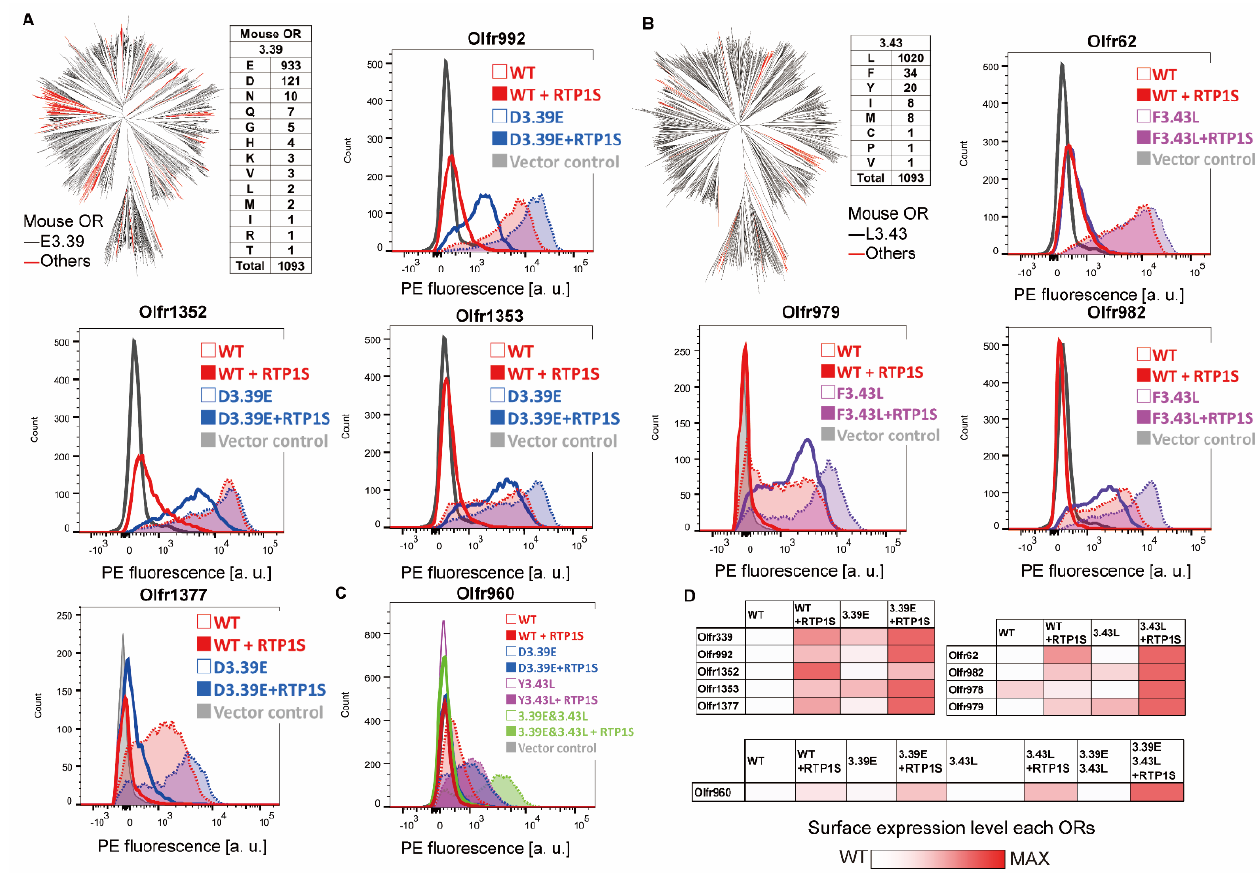
Figure 2. Effect of the 3.39E and 3.43L mutants on mouse ORs. ( A ) Phylogenic tree of mouse ORs showing the E3.39 or others. Red indicates an OR in which the residue of N BW 3.39 is not E (Glu) in 1093 intact mouse ORs. Cell-surface expression of the Rho-tagged ORs and 3.39E mutants. Each mutant was transfected into HEK293T cells, and the cell surface expression level was measured. X-axis: PE fluorescence, Y-axis: cell number. ( B ) Phylogenic tree of mouse ORs showing the L3.43 or others. Red indicates an OR in which the residue of N BW 3.43 is not L (Leu). Cell-surface expression of the Rho-tagged ORs and 3.43L mutants. ( C ) Cell-surface expression of Rho-tagged Ofr960 and its mutants. ( D ) The values of the effect of mutations of 3.39E and 3.43L were used as the max intensity (red) and wild type (white) in each OR, respectively.